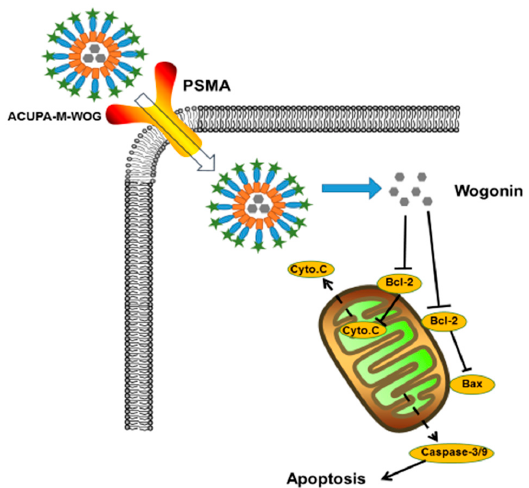
Figure 9. Potential mechanism of ACUPA-M-WOG is dependent on the regulating intrinsic apoptosis. The solid line means that there is direct interaction between the two molecules, while the dash line means that the interaction is indirect.